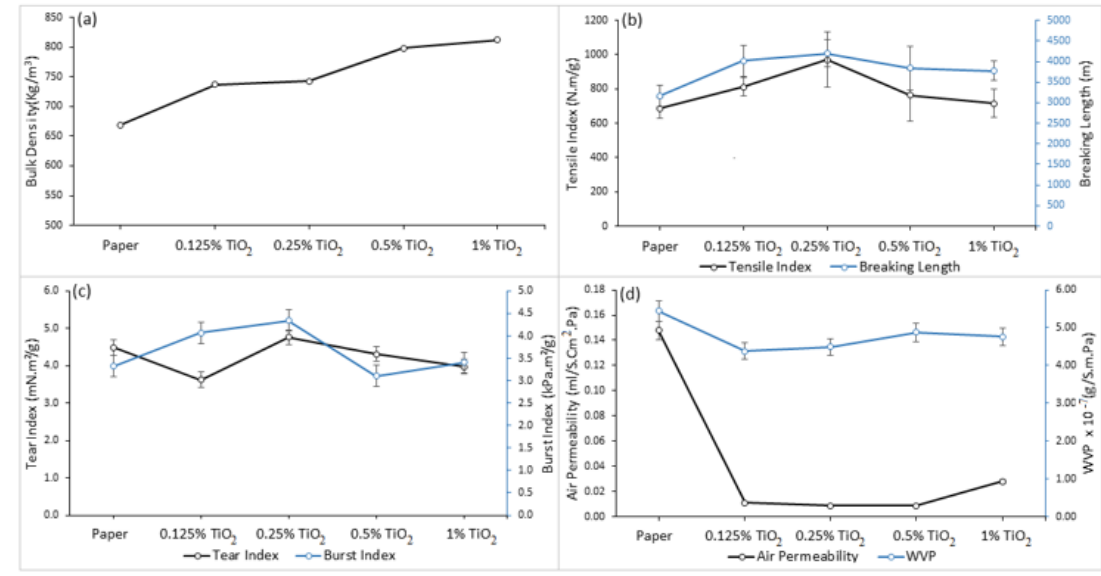
Figure 10. ( a ) Bulk density, ( b ) tensile and breaking length, ( c ) tear and burst index, and ( d ) air and water vapor permeability for paper sheets modified by TiO 2